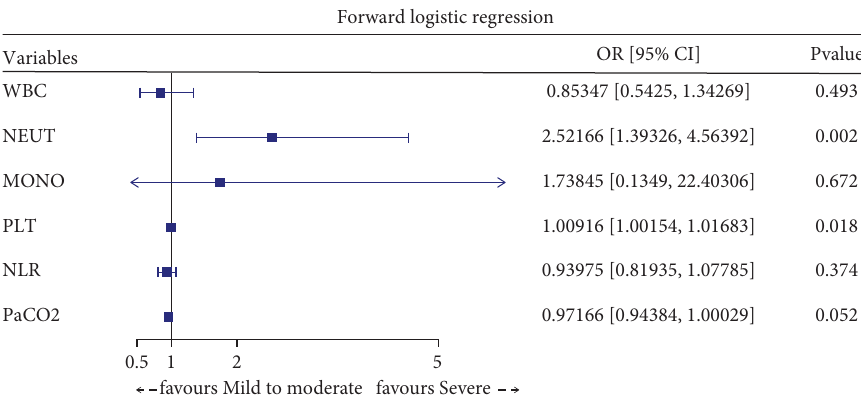
Figure 3: Multivariate logistic regression analysis with forward method.